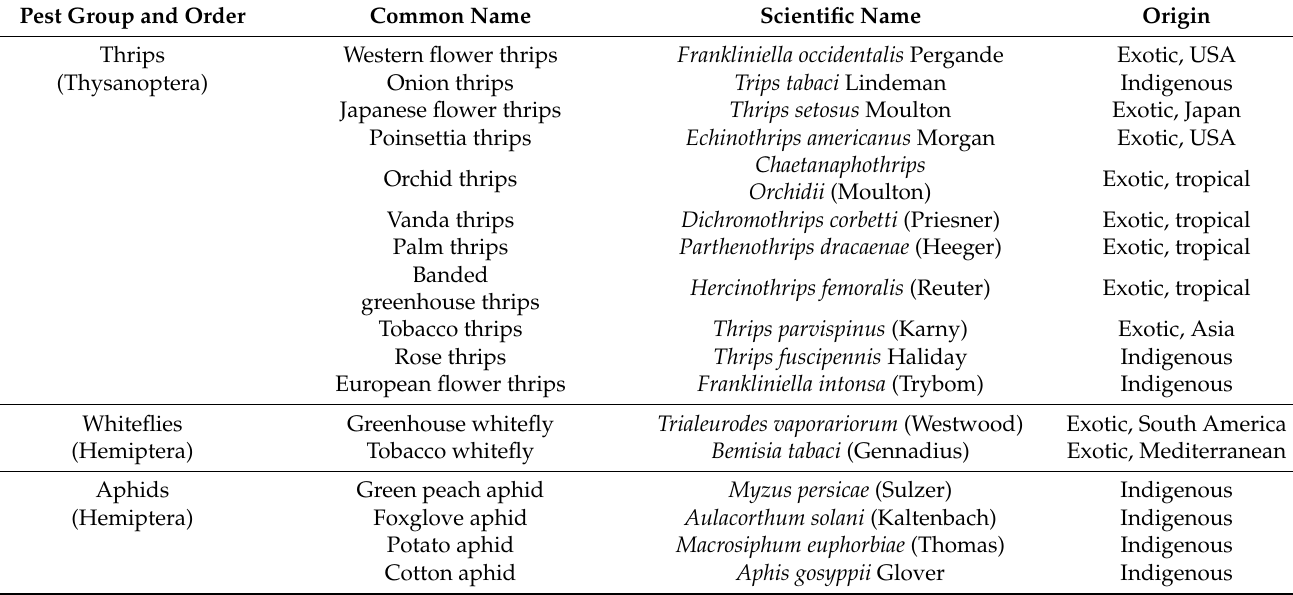
Table 1. Common pests in Northern European greenhouses [22,23] (and personal